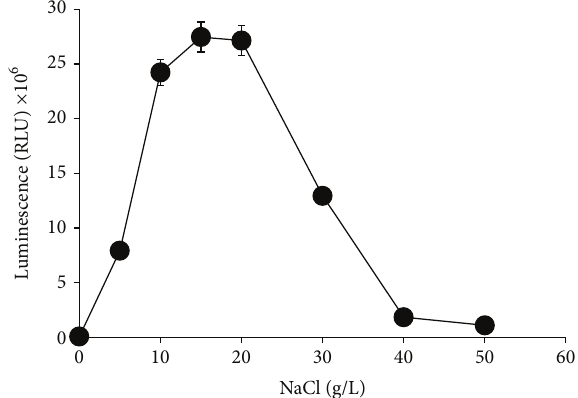
Figure 6: Effects of sodium chloride on bioluminescence produc- tion by Photobacterium sp. strain MIE. The cultures were grown in luminescence media containing different concentrations of sodium chloride and incubated in an orbital shaker (100rpm) for 12 hours at room temperature. Data is mean ± standard error of the mean ( 𝑛 = 3 ).